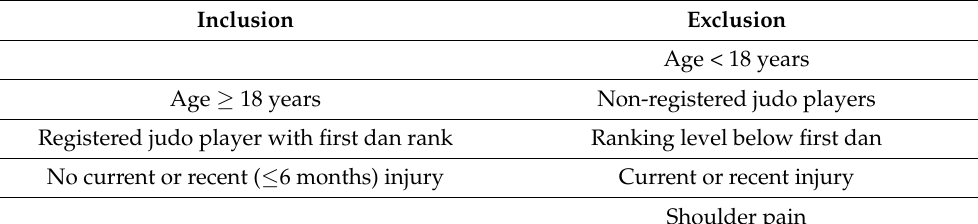
Table 1. Inclusion and exclusion criteria.